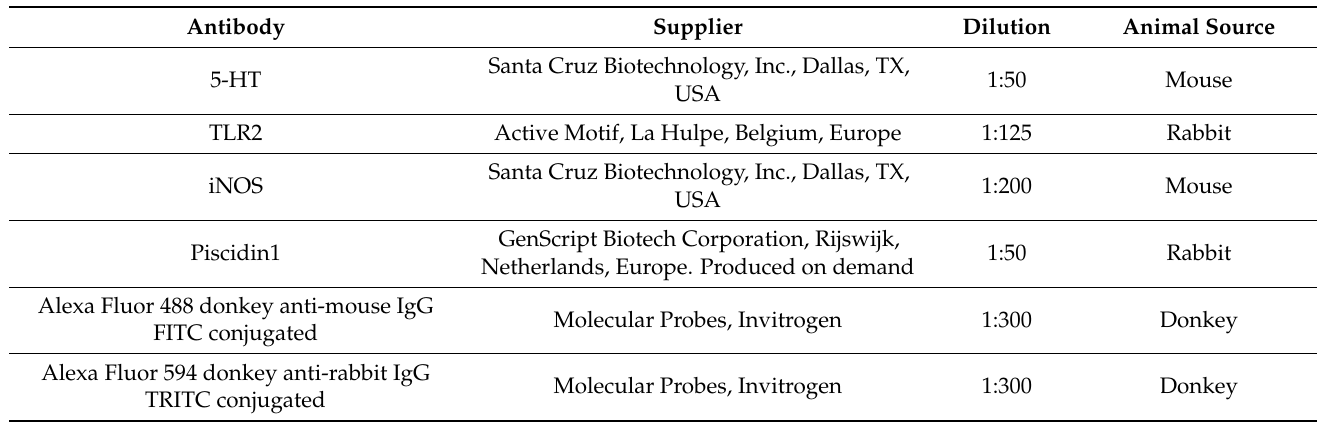
Table 1. Antibodies